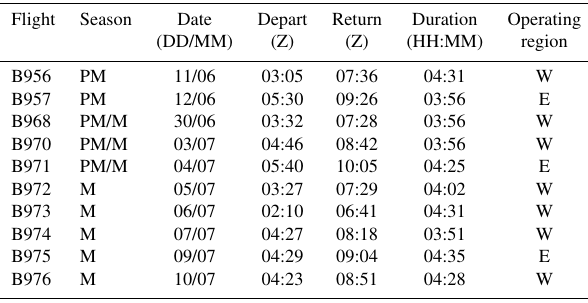
Table 1. Flight summary for operations included in this study. All flights were conducted in northern India in the pre-monsoon (PM) and monsoon (M) season (PM/M season refers to transition period of when the monsoon was arriving in northern India). The dates of the flights are shown, with their respective region of study. Z refers to Zulu